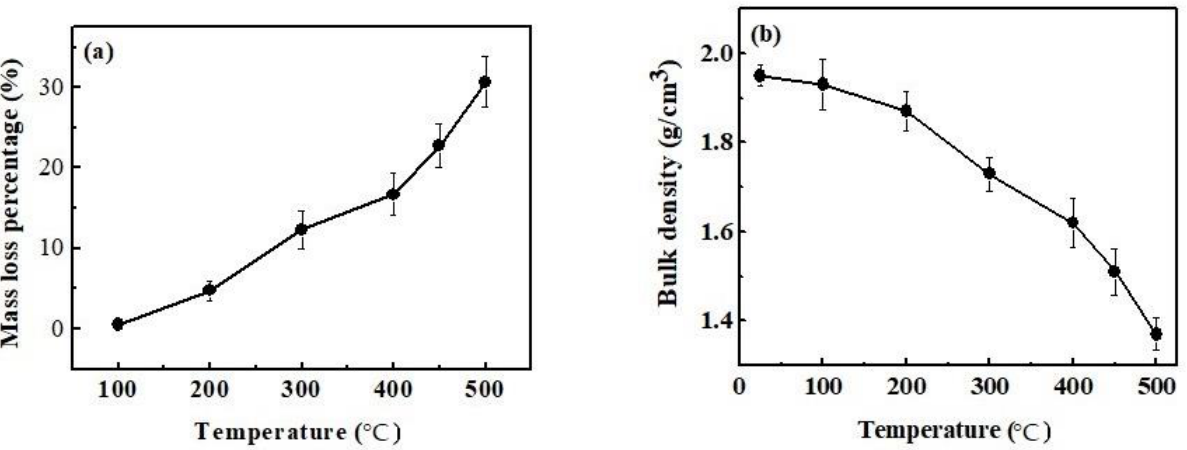
Figure 5. ( a ) Mass loss percentage and ( b ) bulk density of MOC calcinated at different temperatures.